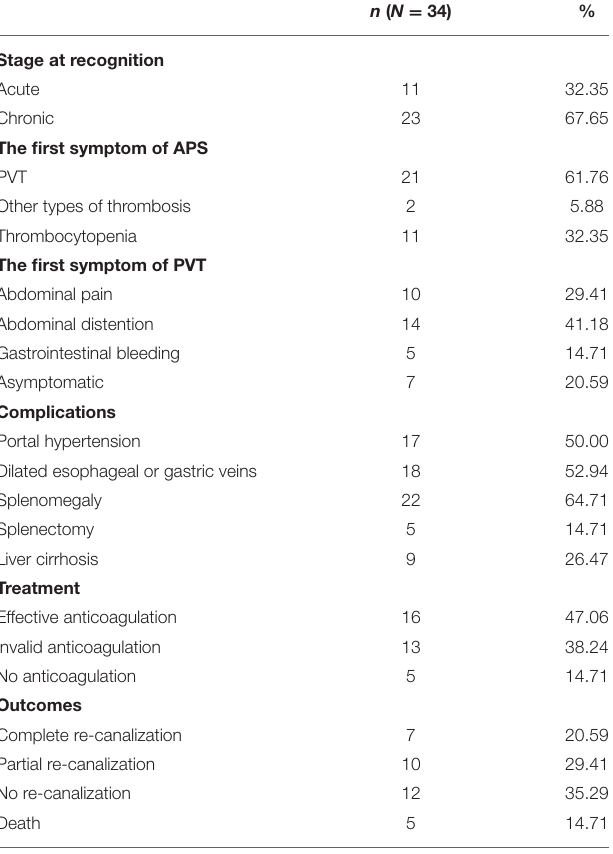
TABLE 2 | The clinical features, treatment and prognosis of APS patients with PVT.